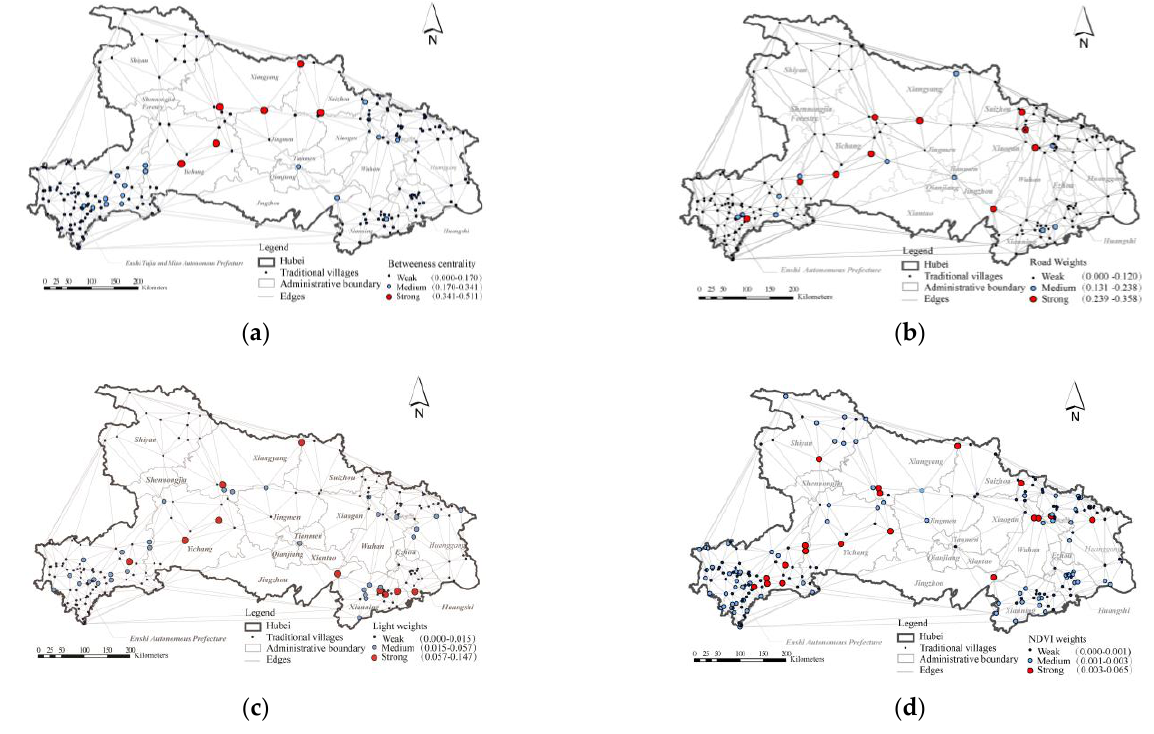
Figure 6. Adjusted network results. ( a ) Original network; ( b ) Results of road weights; ( c ) Results of light weights; ( d ) Results of NDVI weights.